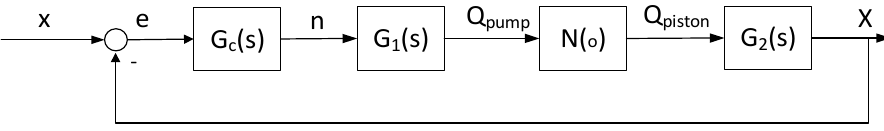
Figure 12. The transfer function diagram of the BHL-EHA system. G s is the transfer function of the controller, In Figure 12, ( ) c ( ) N